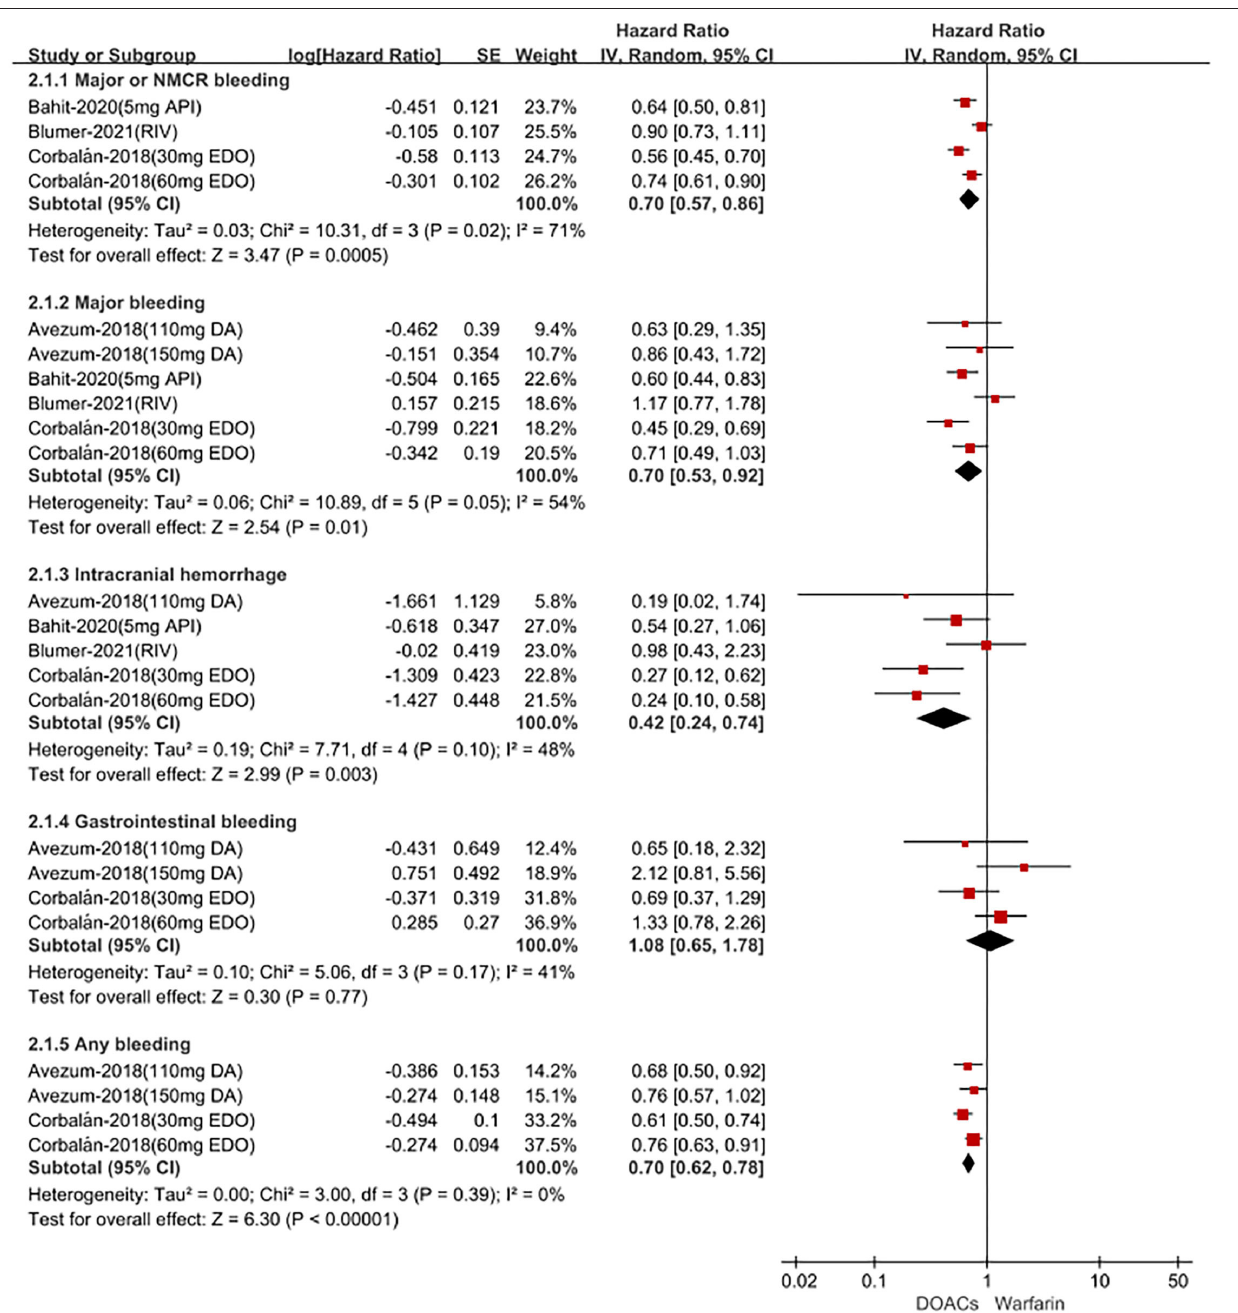
Frontiers in Cardiovascular Medicine |